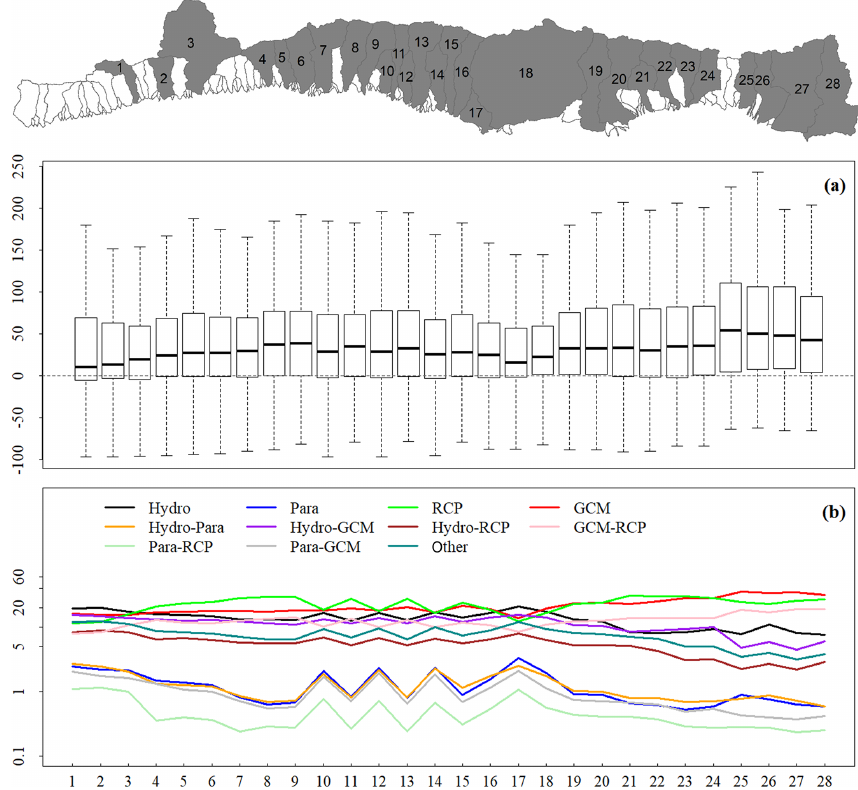
Figure 7. (a) Projected relative changes (%) in 100-year flood discharge ( Q 100 ) in the major SBC watersheds (indicated by the grey wa- tersheds in the map) during 2081–2100 as compared to the historical period (1986–2005); each bar depicts relative changes in minimum, maximum, median, and the 1st and 3rd quartiles for the ensemble outputs; bars from left to right spatially correspond to watersheds from west to east. For clarity, only watersheds with drainage areas larger than 7km 2 , which account for roughly 83% of the study area, are shown. (b) Relative contributions (%) of the uncertainties in the projected changes at each of these watersheds; Hydro: hydrologic models; Para: hydrologic model parameters; GCM: general circulation model; RCP: representative concentration pathway (emission scenarios); “other” is the uncertainty from the third and fourth orders of interactions between the four major sources (i.e., GCMs, RCPs, hydrologic models, and parameters).